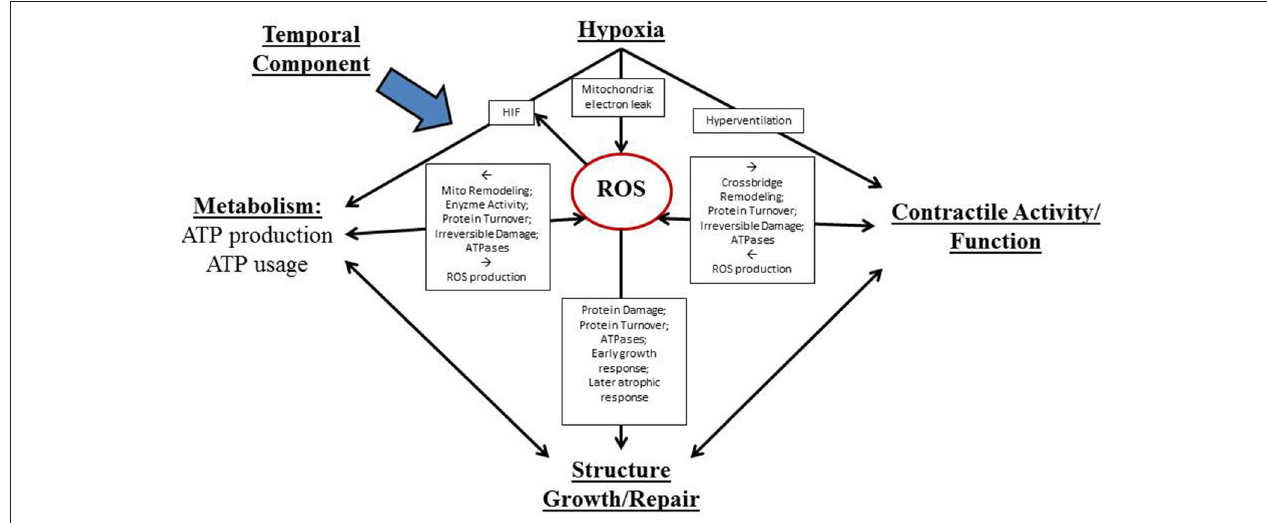
FIGURE 1 | Proposed actions of reactive oxygen species (ROS) as both advantageous and disadvantageous (and ultimately pivotal) determinants of diaphragm muscle adaptation to sustained hypoxia. A temporal component impacts all of these processes. Muscle plasticity is determined by complex interactions between hypoxia/redox stress and three major inter-related processes that are fundamental to muscle performance: contractile activity, metabolism, and structure/growth/repair.